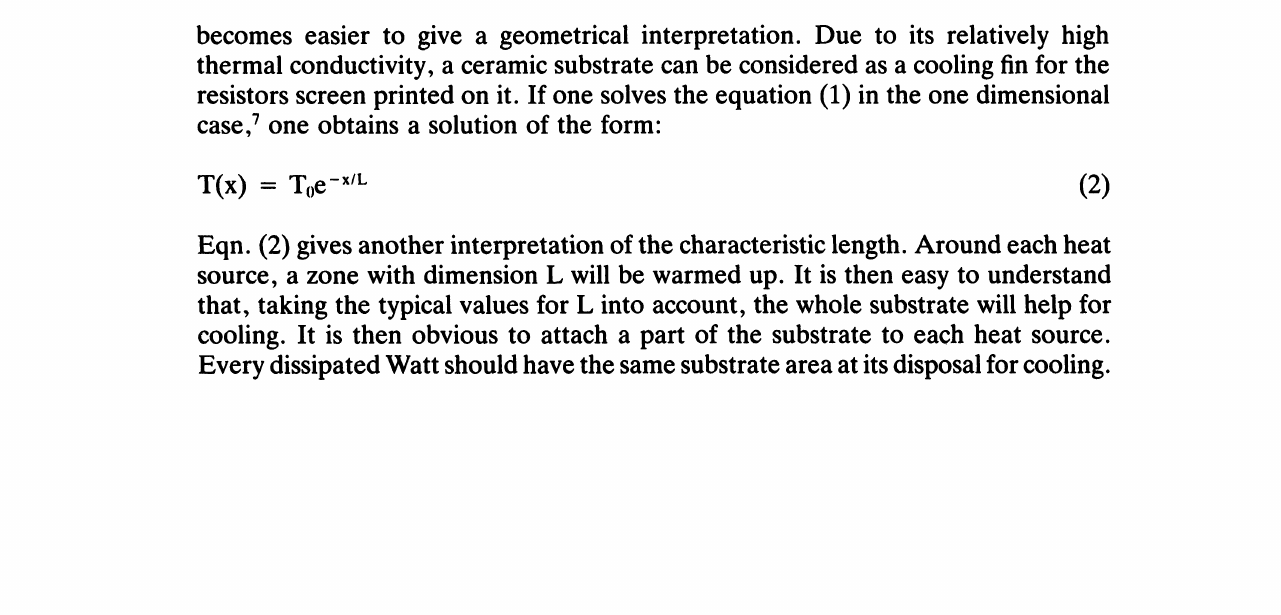
FIGURE 2 Resistor temperature as function of position for the case of Fig. 1. Temperatures are normalised to the value T,,x occuring when the resistors are placed in the